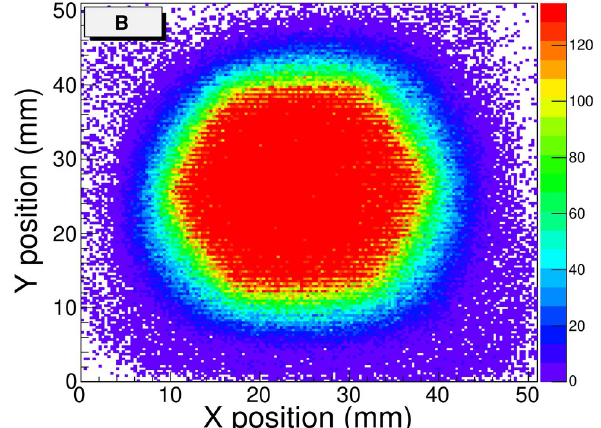
Fig. 8: Simulated (A) and experimental (B) 2-d images of a hexagonal BGO detector reconstructed with the LaBr 3 (Ce)-PSPMT, in coincidence mode with energy-gating on the 511 keV photo-peak in both detectors.